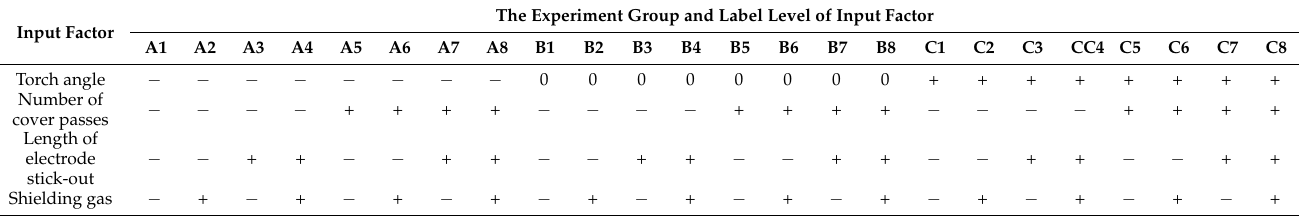
Table 3. Summary of the experimental design.